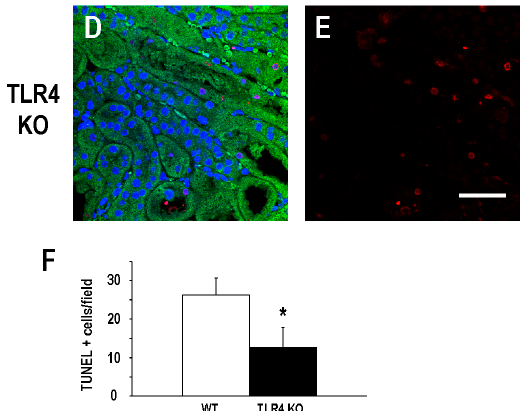
Figure 1. Deletion of TLR4 confers acute protection in a model of ischemic AKI. ( A ) Mean serum creatinine values (±SD) at 24 h following a 19-min bilateral renal artery clamp in background control (WT) and TLR4-deletion (TLR4 KO) mice. Representative images (60×) of TUNEL staining are shown for background control (WT; B , C ) and TLR4-deletion (TLR4 KO; D , E ) mice at 24 h following a 19-min bilateral renal artery clamp; Panels B and D are composite images of TUNEL (red), DAPI (blue), and tubular auto-fluorescence (green); Panels C and E are fields identical to the adjacent composite field demonstrating TUNEL staining alone. Quantitation of TUNEL positive tubular cells at 24 h is demonstrated in panel F (mean TUNEL-positive tubular cells/field ±SD; 5–7 fields/animal; n = 4, * p < 0.05). TUNEL-positive tubular cells were counted by a blinded observer. Scale bar = 50 µm.